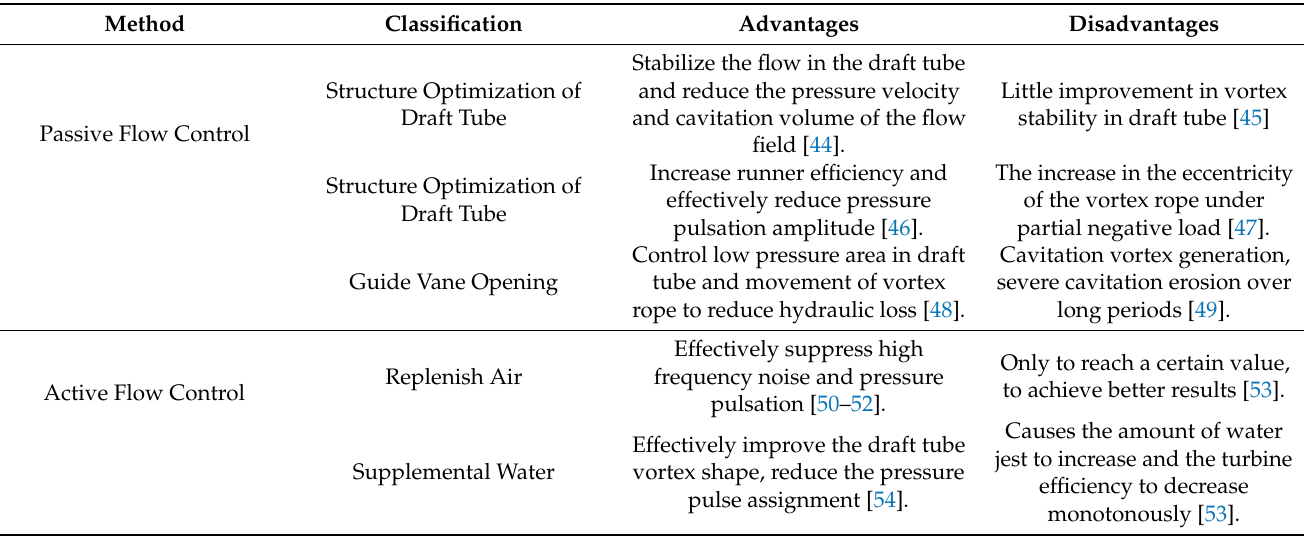
Table 1. Methods of suppressing vortex and their advantages and